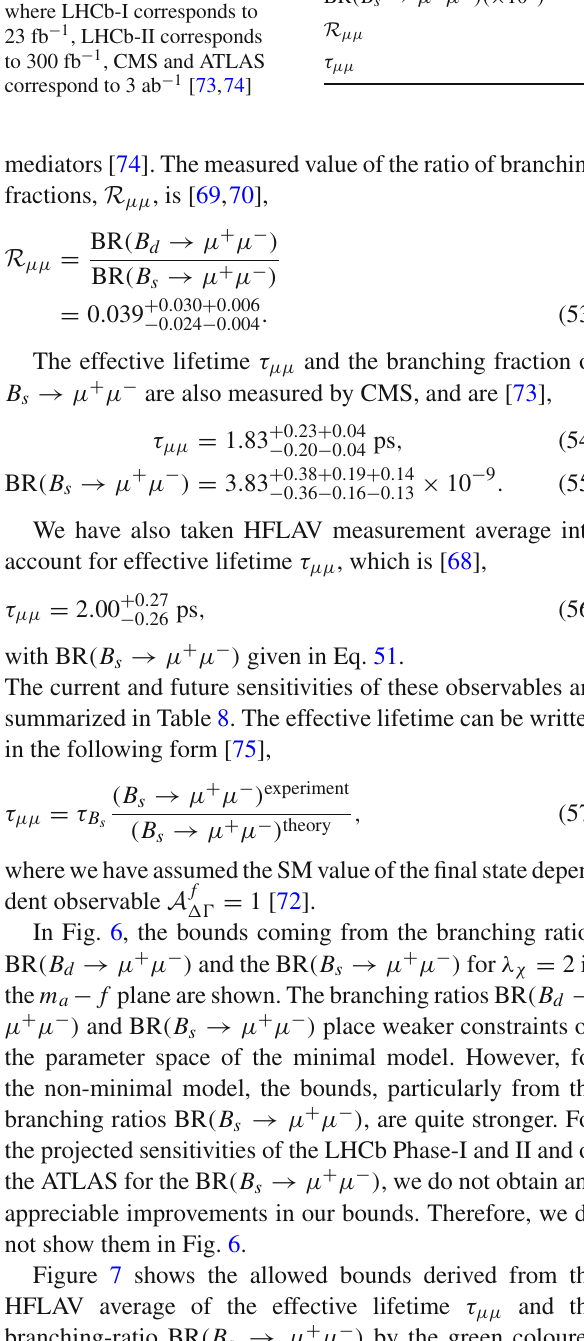
expected experimental precision for rare B decays observables where LHCb-I corresponds to 23 fb − 1 , LHCb-II corresponds to 300 fb − 1 , CMS and